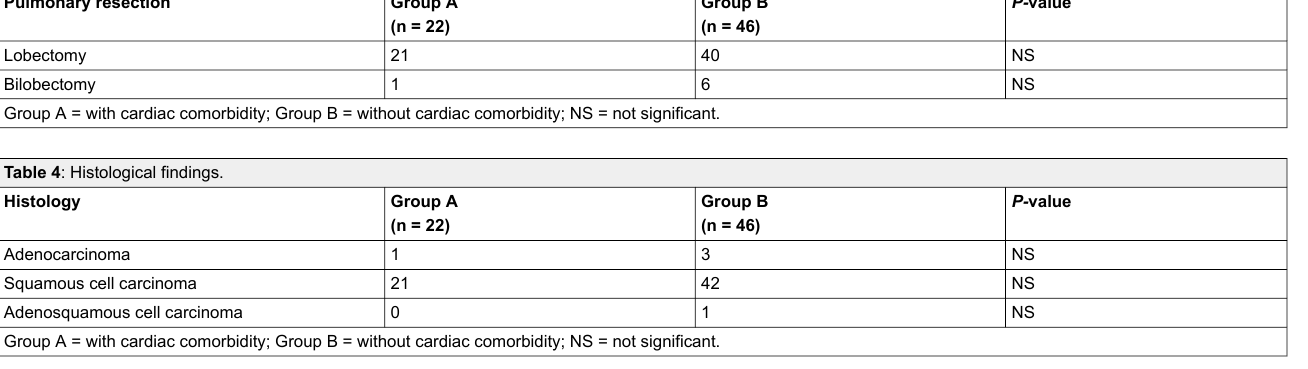
Table 3: Type of pulmonary resection.